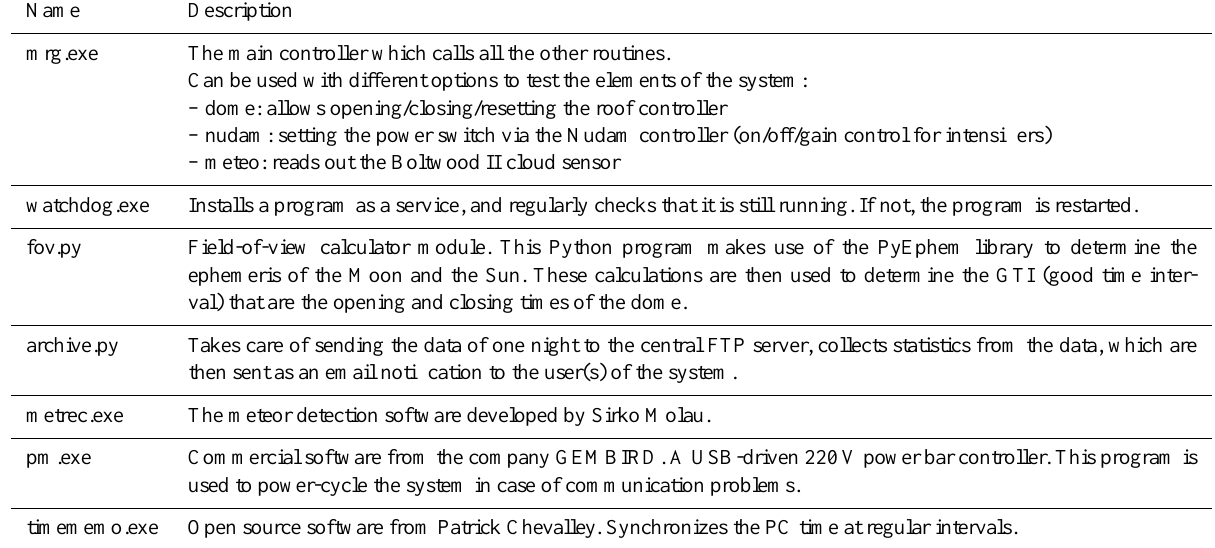
Table 2. C ++ and Python scripts developed as part of the “mrg”